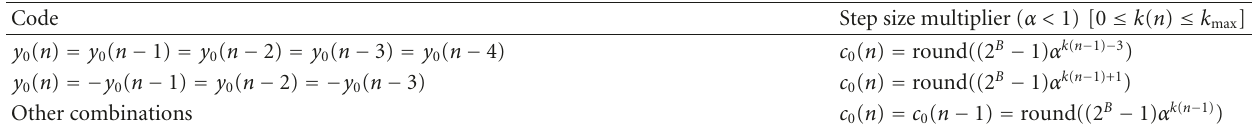
Table 1: Adaptation algorithm.